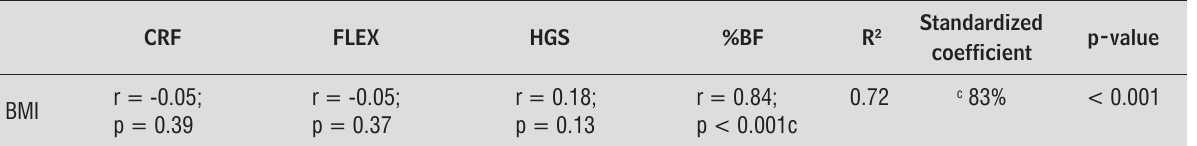
Standardized R 2 coefficient